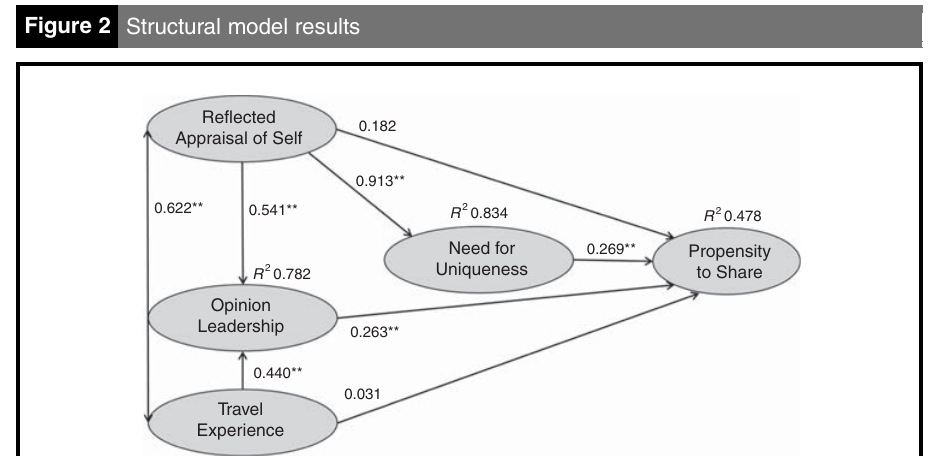
Figure 2 Structural model